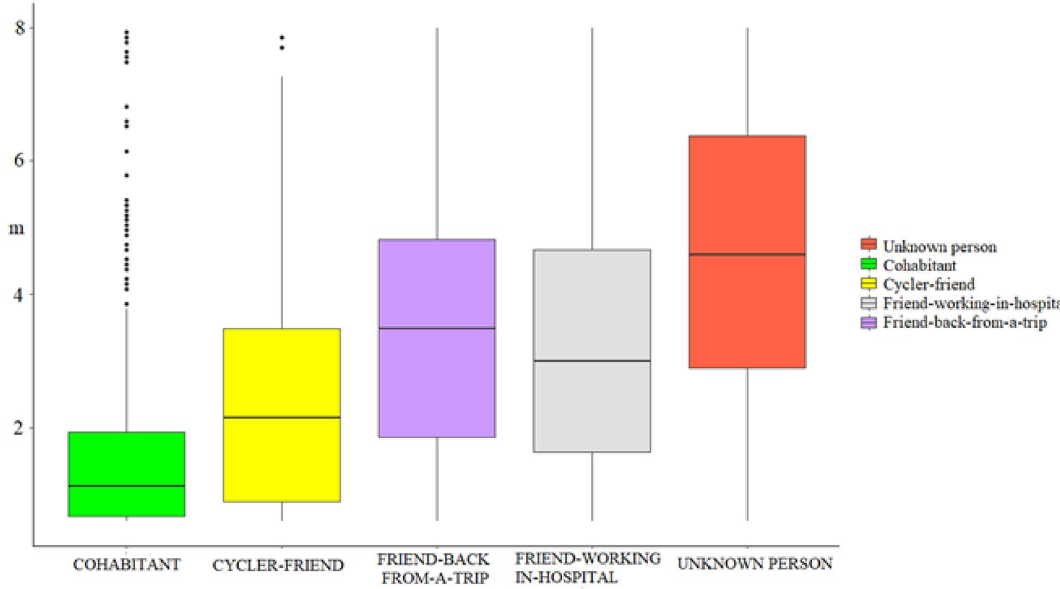
Figure 2. The graph shows the predicted values of the third model, which is the one with the best fitting. The analysis yielded a significant main effect of the Context (F(4,1735) = 226.51, p = 0.001). The results show that the preferred interpersonal distance threshold is more extended with the UNKNOWN PERSON than with all the other contexts: COHABITANT, which was the most reduced one compared with the CYCLER-FRIEND, the FRIEND-WORKING-IN-HOSPITAL and the FRIEND-BACK-FROM-A-TRIP. All these measures significantly differed from each other, p<0.00001. Only the preferred interpersonal distance with the FRIEND-WORKING- IN-HOSPITAL was not significantly different from the preferred interpersonal distance with the FRIEND- BACK-FROM-A-TRIP, p = .1009, Horizontal lines in the boxes indicate the median, upper and lower borders indicate I and III quartile, "whiskers" extend to the farthest points that are not outliers, dots represent outlier